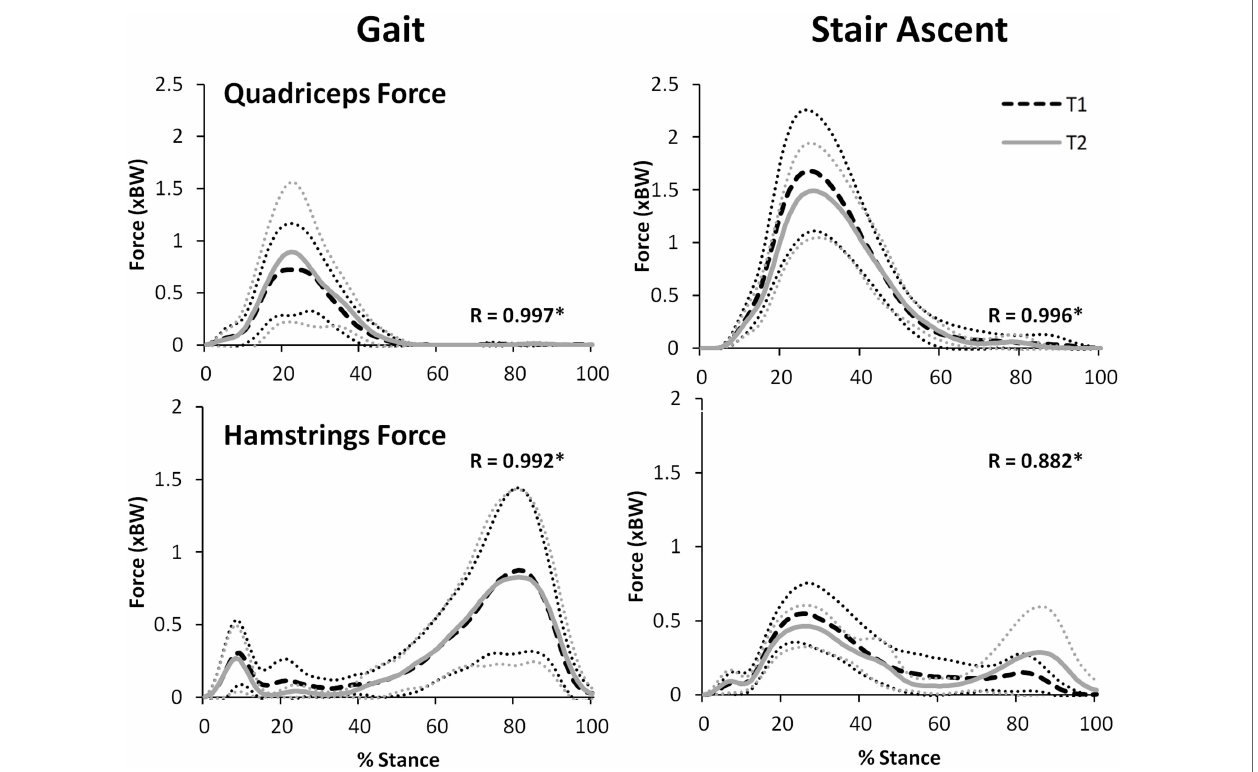
FIGURE 9 | A comparison of group mean quadriceps and hamstring forces from two data collection sessions separated by 24h. 95% confidence intervals for session one and two are represented by the thin, dotted black and gray lines, respectively. Correlation coefficients ( R ) are also included where * indicates a significant correlation ( p <